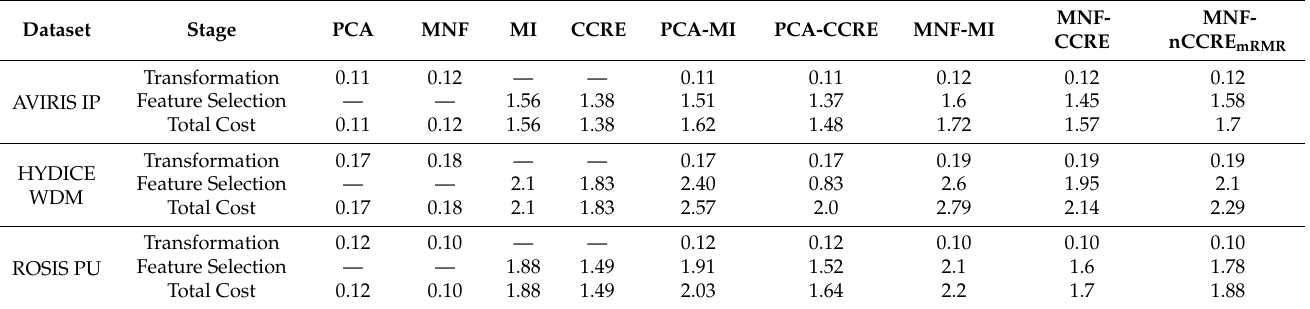
Table 16. The computational time (in second) of each method on AVIRIS IP, HYDICE WDM, and ROSIS PU